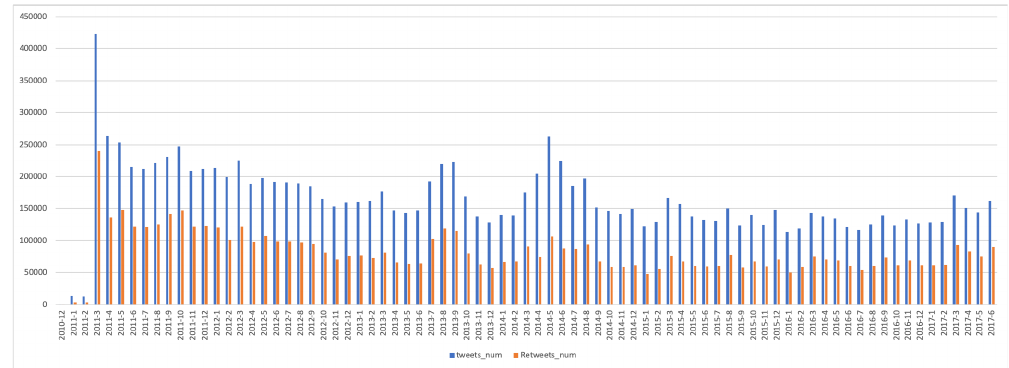
Figure 1. Number of original tweets and retweets per